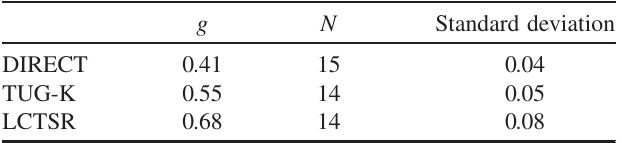
TABLE III. Average normalized gains on two conceptual in- ventories and the LCTSR for students participating in a con- ceptual physics course with and without explicit reasoning